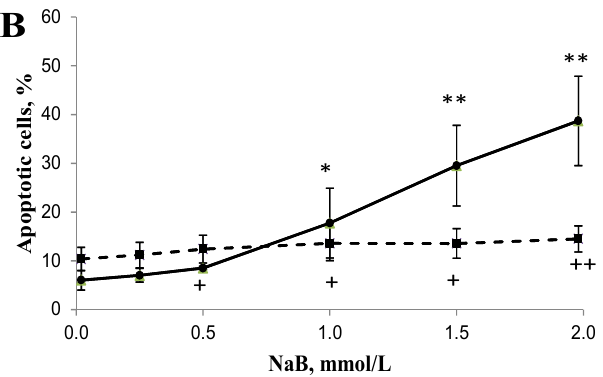
Figure 2. Effect of sodium butyrate (NaB) treatment for ( A ) 24 h and ( B ) 48 h on the apoptosis (including both early and late apoptosis) of cancerous HCT116 (solid lines) and non ‐ cancerous NCM460 (dashed lines) colon cells. Values are means ± SD, n = 5 to 6. There was a significant interaction between cell type and concentration at 24 h ( p < 0.0001) and at 48 h ( p < 0.0001) by two ‐ way ANOVA. * Different from HCT116 control (0 mmol/L NaB); * p < 0.05, ** p < 0.0001. + Different from NCM460 control (0 mmol/L NaB); + p < 0.05, ++ p < 0.0001.